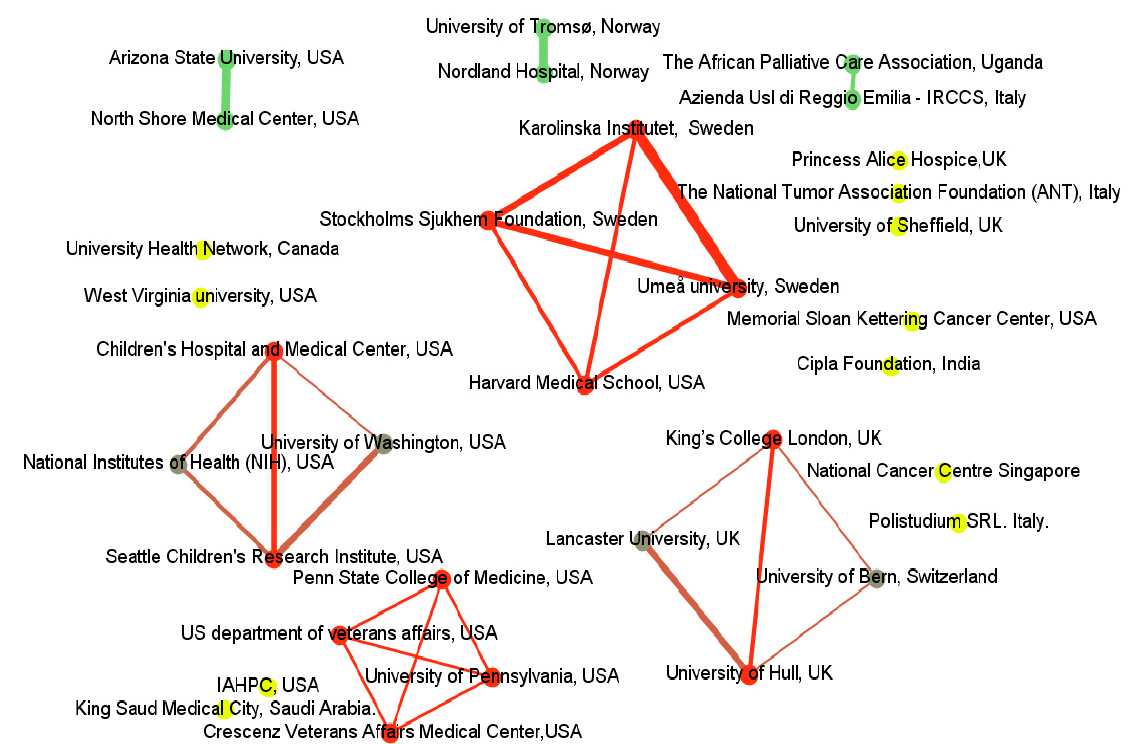
Figure 3. Network visualization map of cooperation across institutions created using Gephi. Nodes in the resultant network were recolored based on hyperlink-induced topic search value. Nodes with red color represent higher values that reflect highly influential institutions, followed by nodes with green and yellow. The thickness line between nodes also presents a strong relationship between institutions.